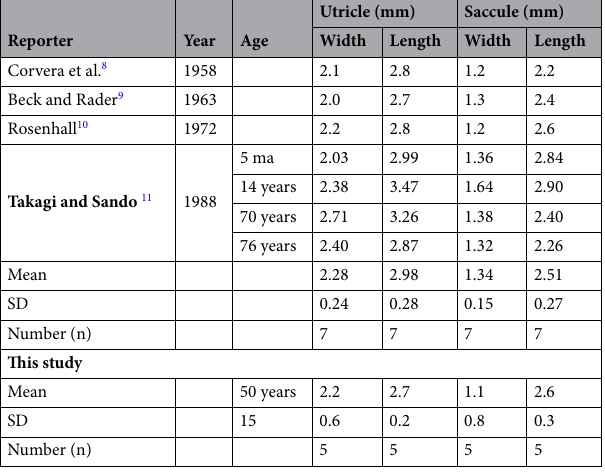
Table 2. The histological dimensions of the utricle and the saccule 8–11